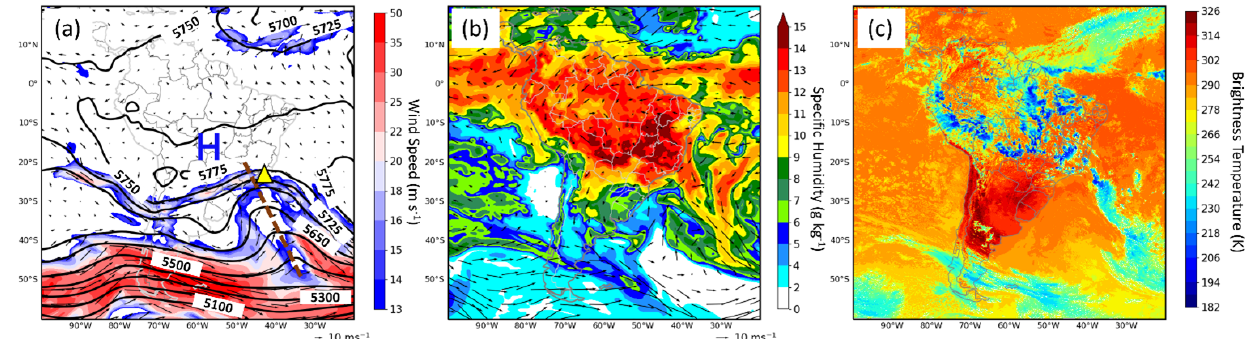
Figure 2. Large-scale environmental variables and satellite observation at 16:00LT. (a) Wind speed (shading), geopotential height (contour), and winds (arrow) at 500hPa, where the trough line is indicated using a dashed brown line and the location of Petrópolis is highlighted by a yellow triangle. (b) Specific humidity (shading) and winds (arrow) at 850hPa. (c) Merged IR brightness temperature, where cold color represents the presence of deep clouds.